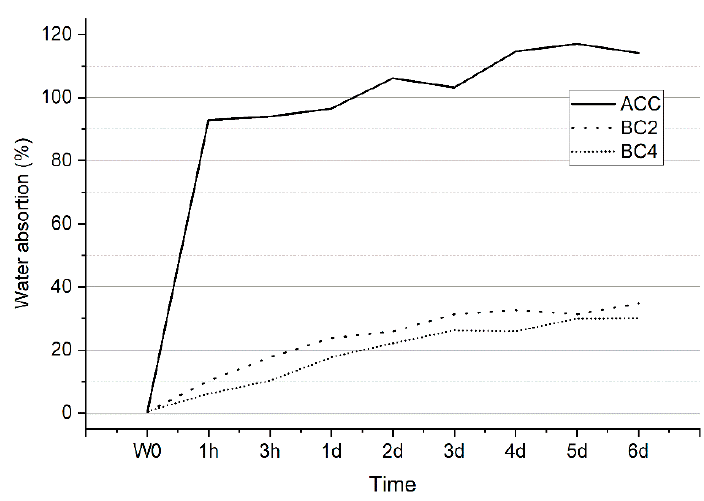
Figure 9. Results from a water absorption test of 6 days, where W 0 stands for dry